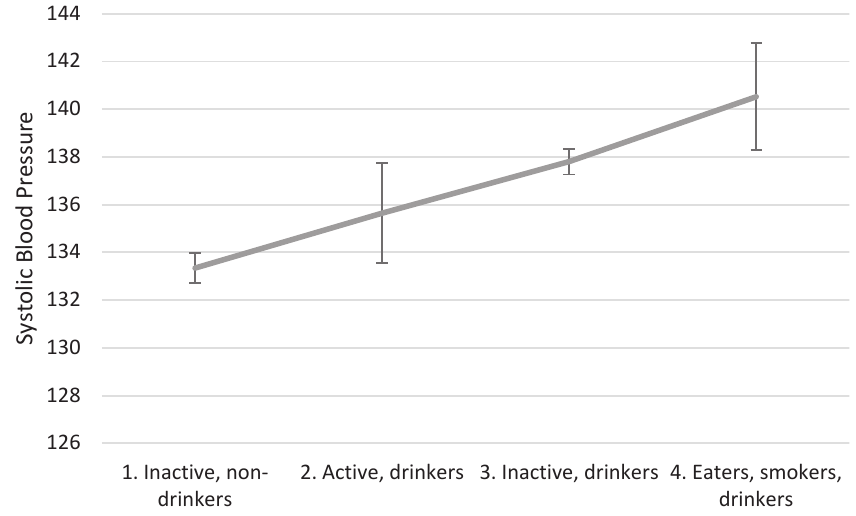
Figure 1. Values of systolic blood pressure by cluster for men, predicted by ordered linear regression analysis adjusting for age, income and classi fi cation error, with 95% con fi dence